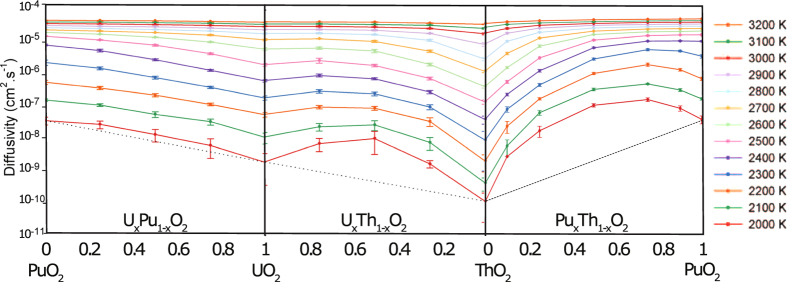
Oxygen diffusivity as a function of composition for (PuxU1−x)O2, (UxTh1−x)O2 and (PuxTh1−x)O2 for 10 randomly generated structures, averaged for each composition. The error bars correspond to the standard deviation of the 10 runs.